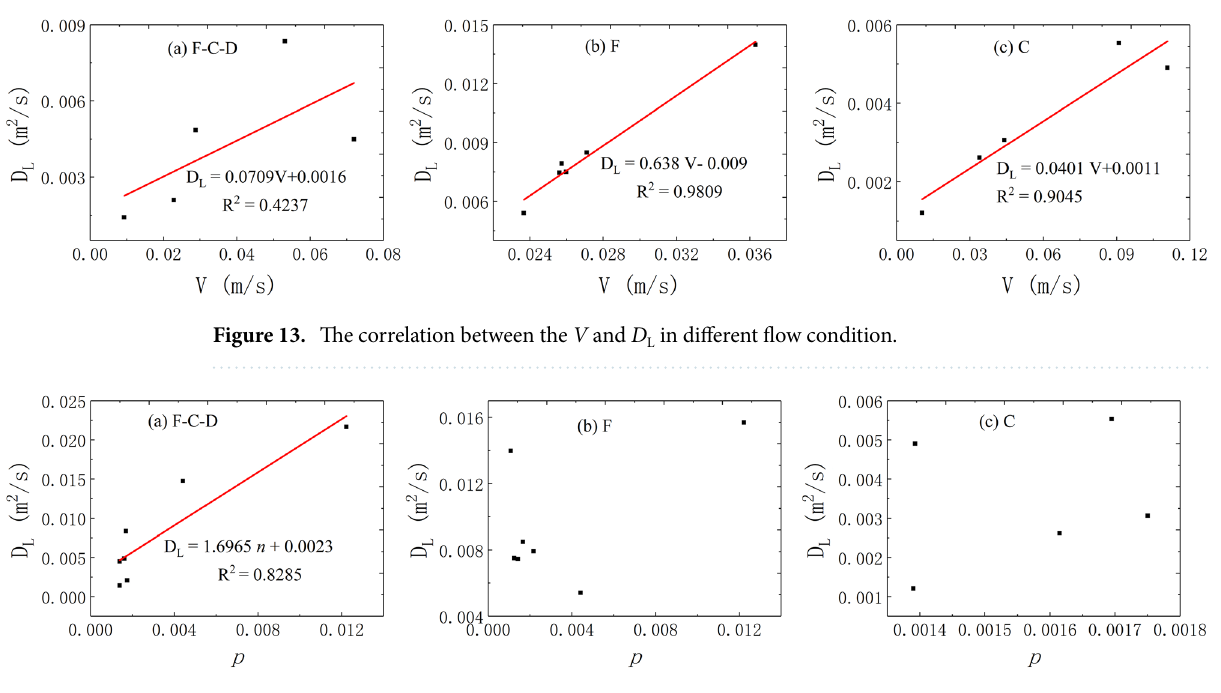
Figure 14. The correlation between the V and D L in different flow